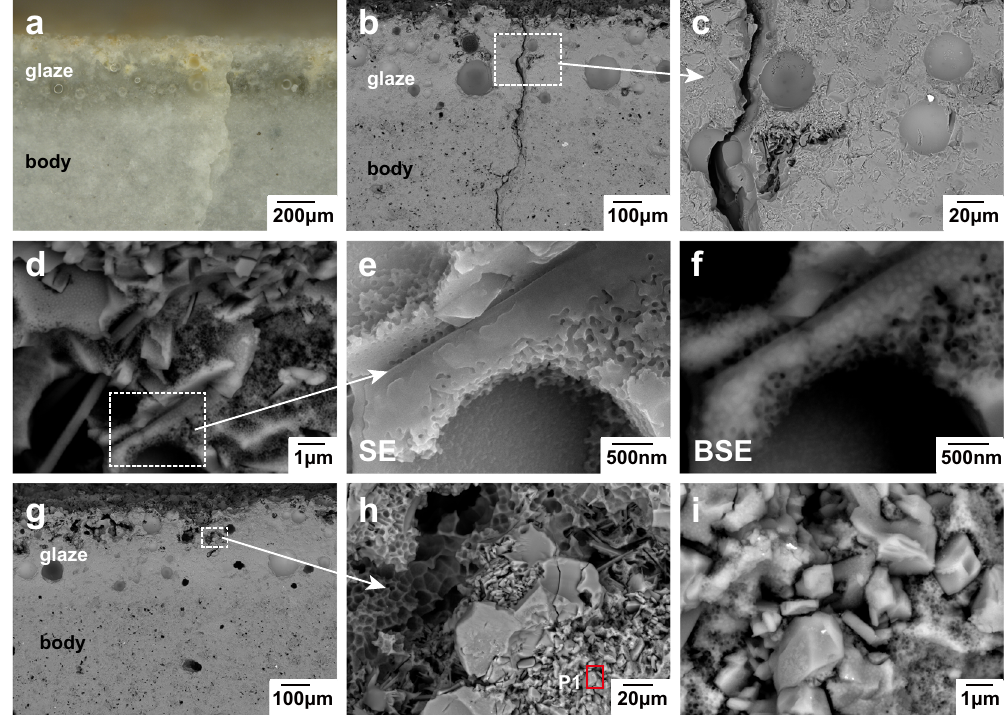
Fig. 10 Corrosion morphology of sample No. 10. a and b are the OM and SEM images of the polished cross section, respectively; c SEM image of the rectangle region in b : the corrosion hole near a crack; d SEM image of the plate-like crystal in the hole and the corroded glass phase nearby; e and f are the secondary electron image and backscattered electron image of the porous glass phase in d , respectively; g SEM image of the polished cross section: the area with many interconnected craters near the glaze surface; h SEM image of a crater in the glaze; i SEM image of the anorthite crystals and the corroded glass phase nearby in a